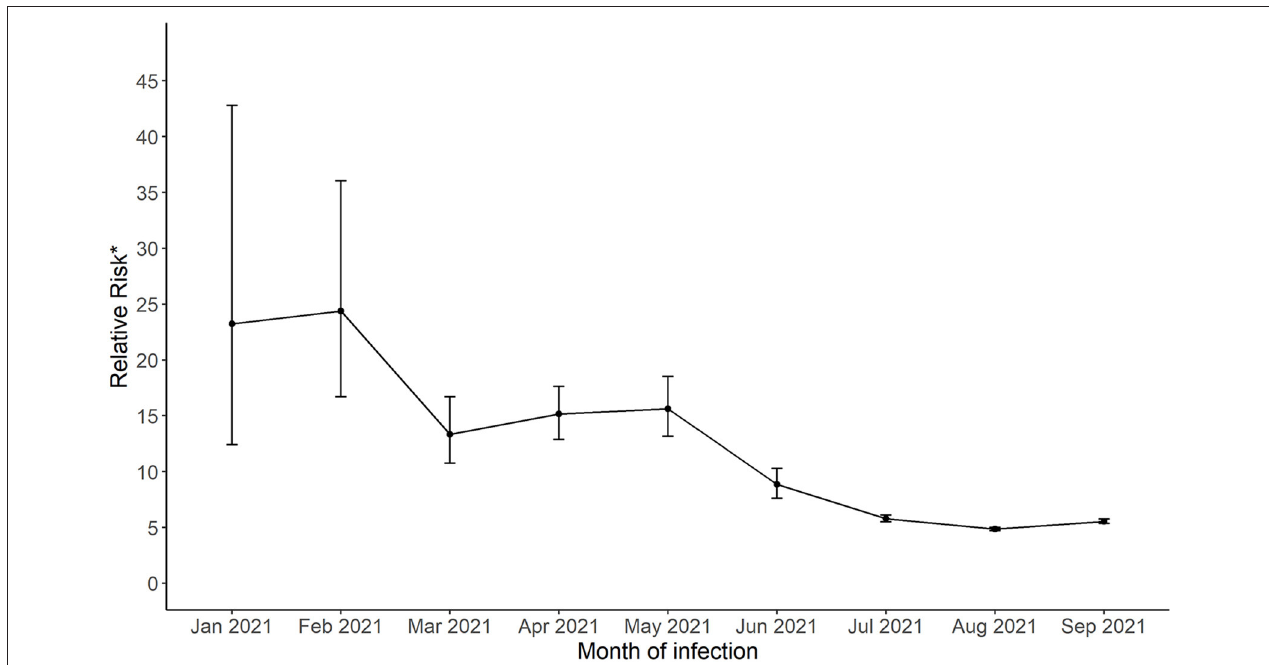
FIGURE 2 | The relative risk of a positive SARS-CoV-2 for not fully vaccinated compared to fully vaccinated groups living in Harris County Jurisdiction area from January, 2021 to September, 2021. *Relative risk = Pr ( positive test | not fully vaccinated) . Pr ( positive test | fully vaccinated)